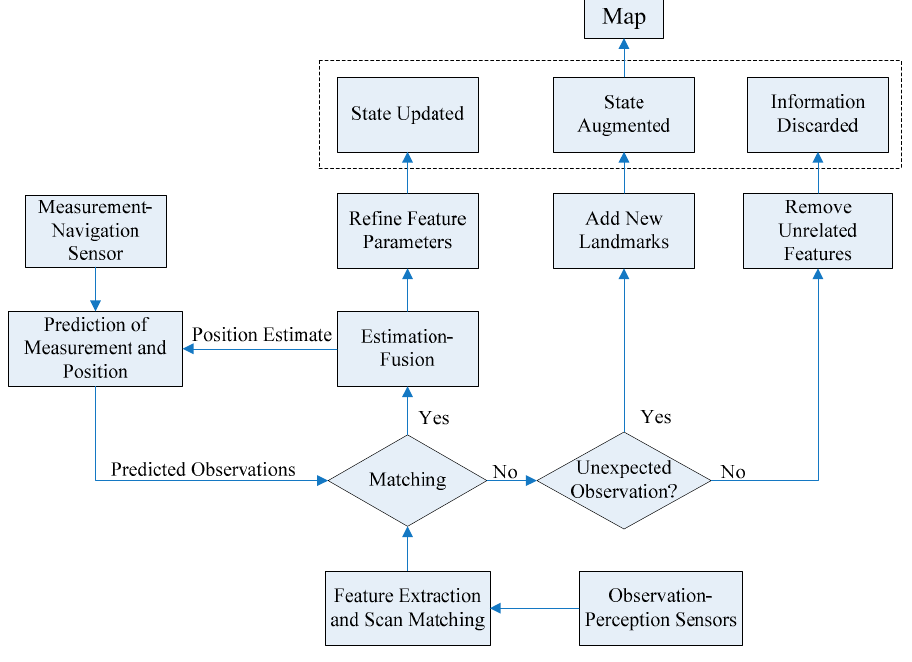
Figure 11. The flow chart of SLAM procedure based on an AEKF. Modified after [27].